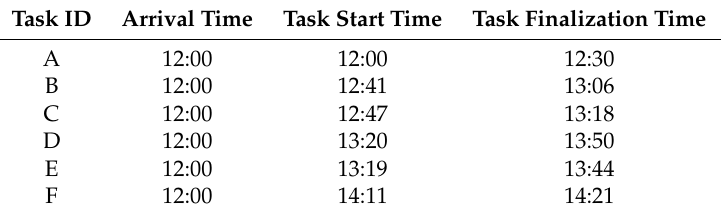
Table 9. Start times of DAG task nodes from Figure 2.